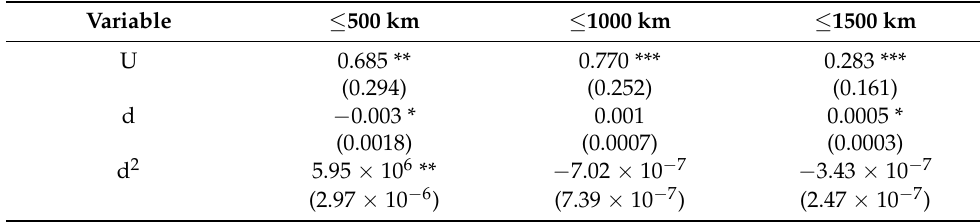
Table A1. The robust results—The economic impact of building the TGD by different groups of distance (The upstream